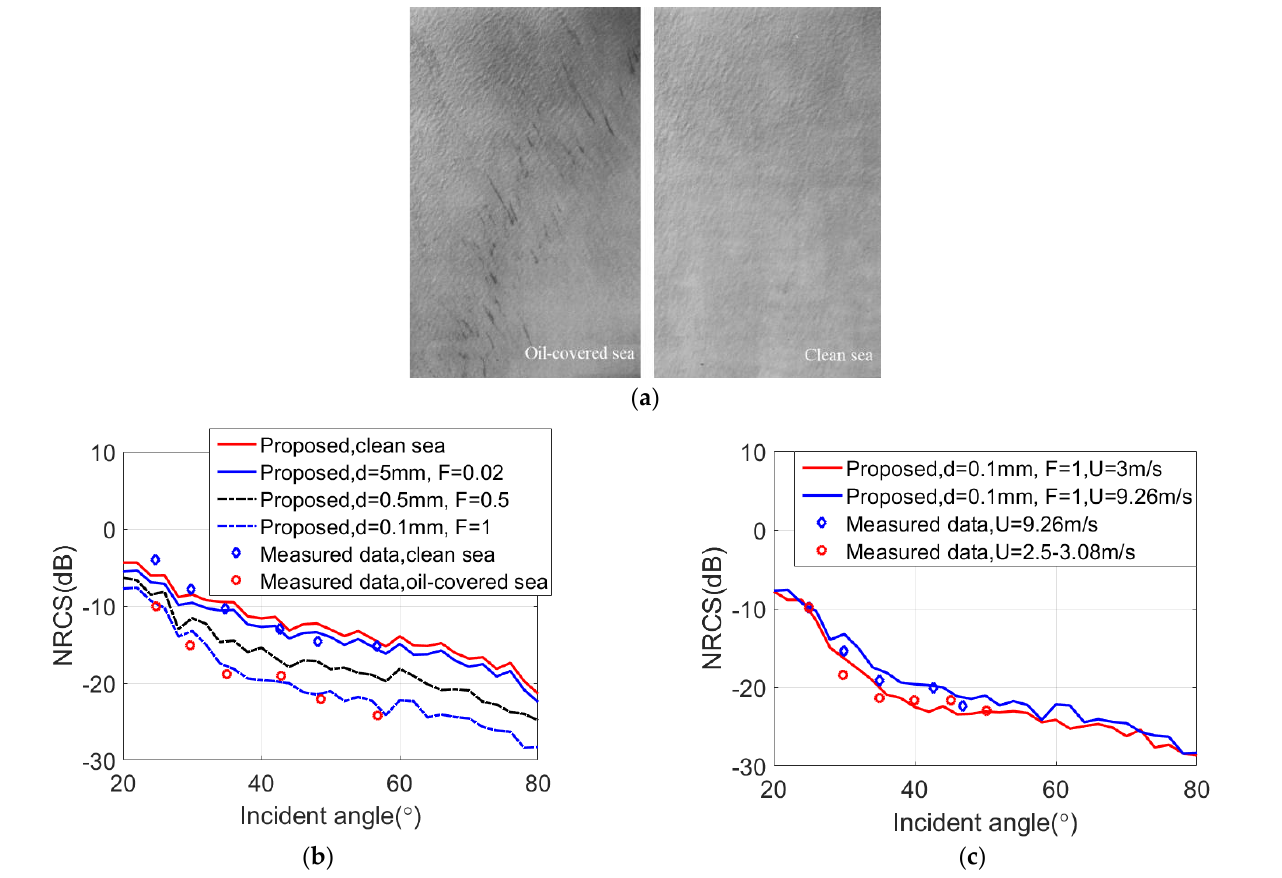
Figure 7. ( a ) The NASA/MSC photograph of the oil–covered sea surface area and clean sea; ( b ) Comparison of experimental data and simulation results; ( c ) Comparison of experimental data and simulation results for different wind speeds.